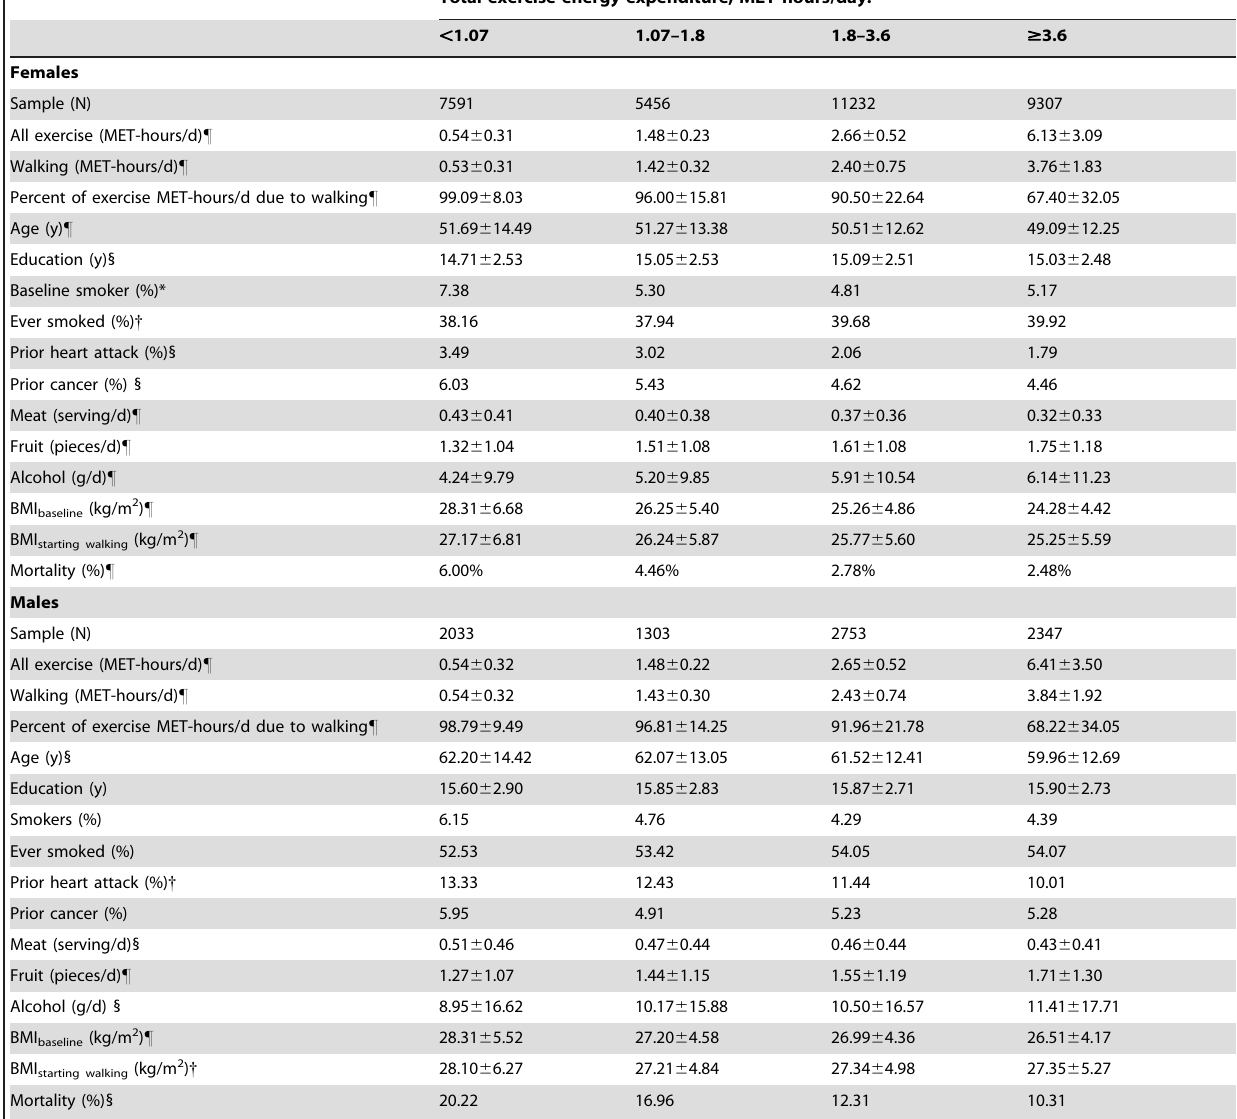
Total exercise energy expenditure,